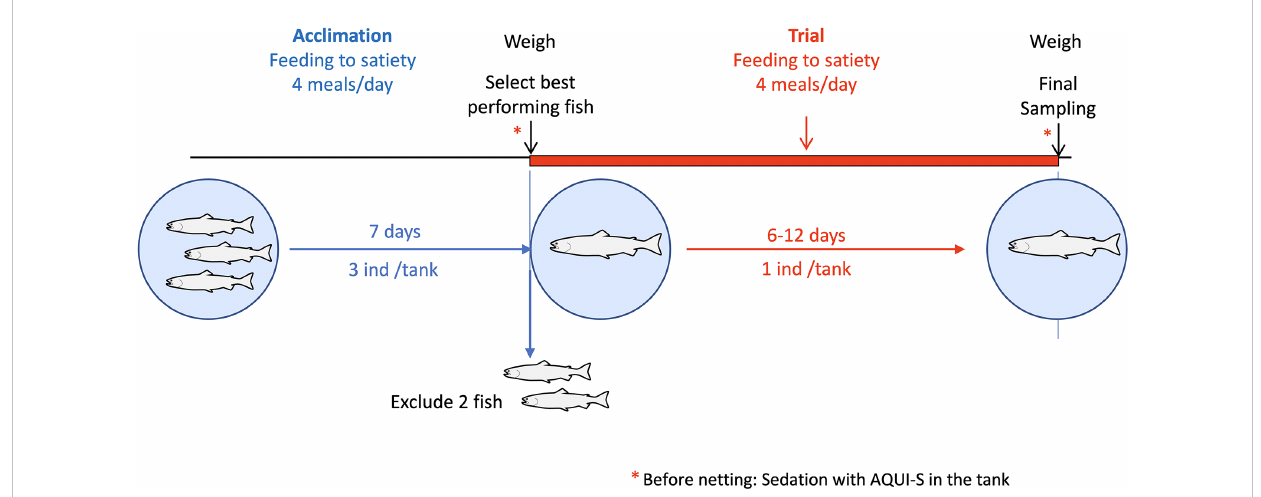
FIGURE 1 Experimental design of trials investigating individual feed intake in Atlantic salmon post smolts handfed to satiety. Fish (n=3 per tank) were acclimatized for 7 days. At the start of each trial fi sh weight was recorded and the best performing fi sh selected. Individual feed intake (pellets consumed per meal) was recorded for 6 (Trial 1), 12 (Trial 2) and 11 (Trial 3) days. Final fi sh weight was recorded at the end of each